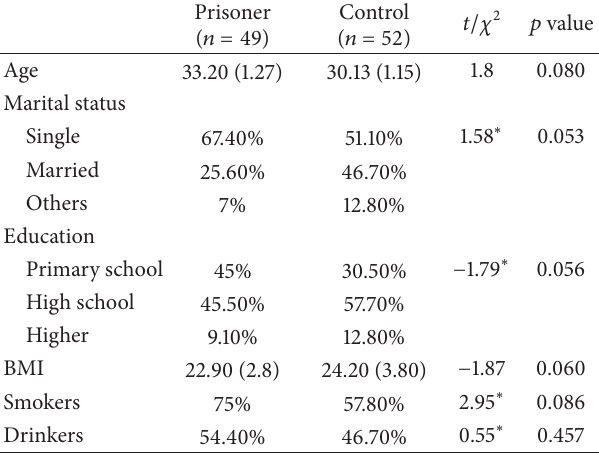
Table 1: Demographic summary of the participants.